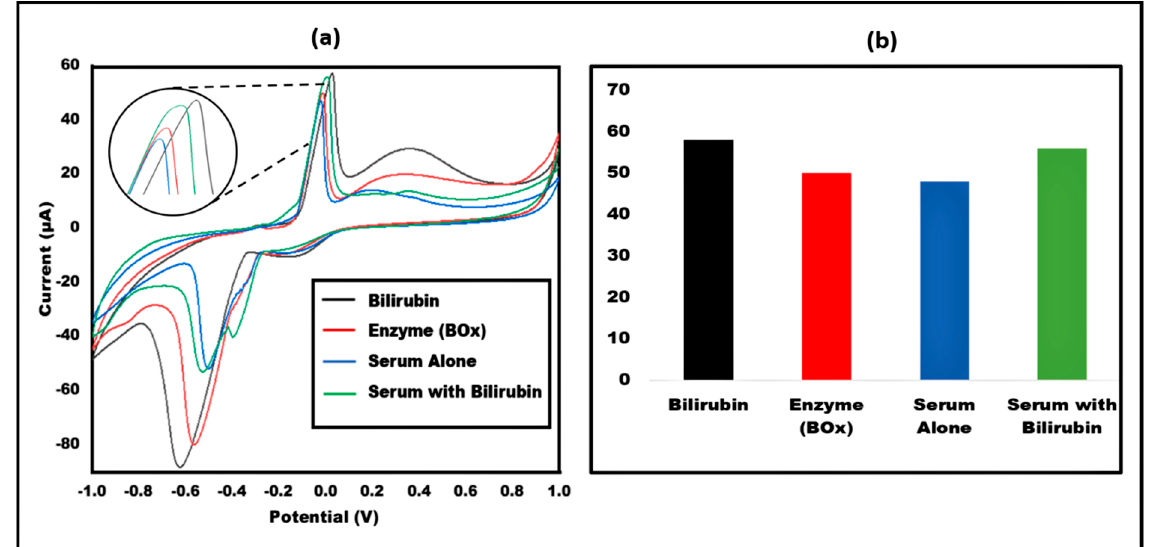
Figure 9. (a) Cyclic Voltammetry peak showing current study of Bilirubin in Artificial human serum utilizing fabricated paper-based sensor (b) Bar graph depicting the current study of Bilirubin compared to enzyme, Serum alone and Serum with bilirubin.